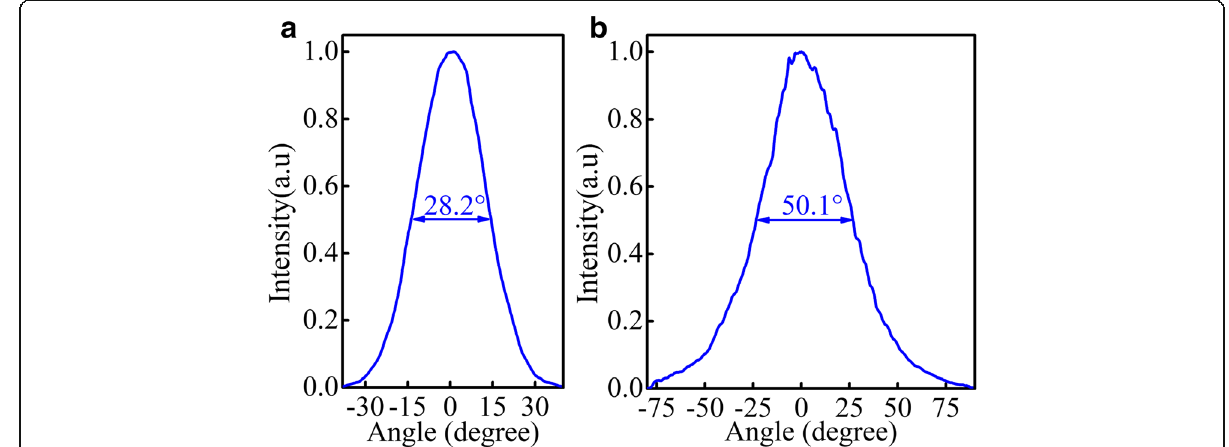
Fig. 7 a The far-field profile along the ridge-width direction. b The far-field profile along the epitaxial growth